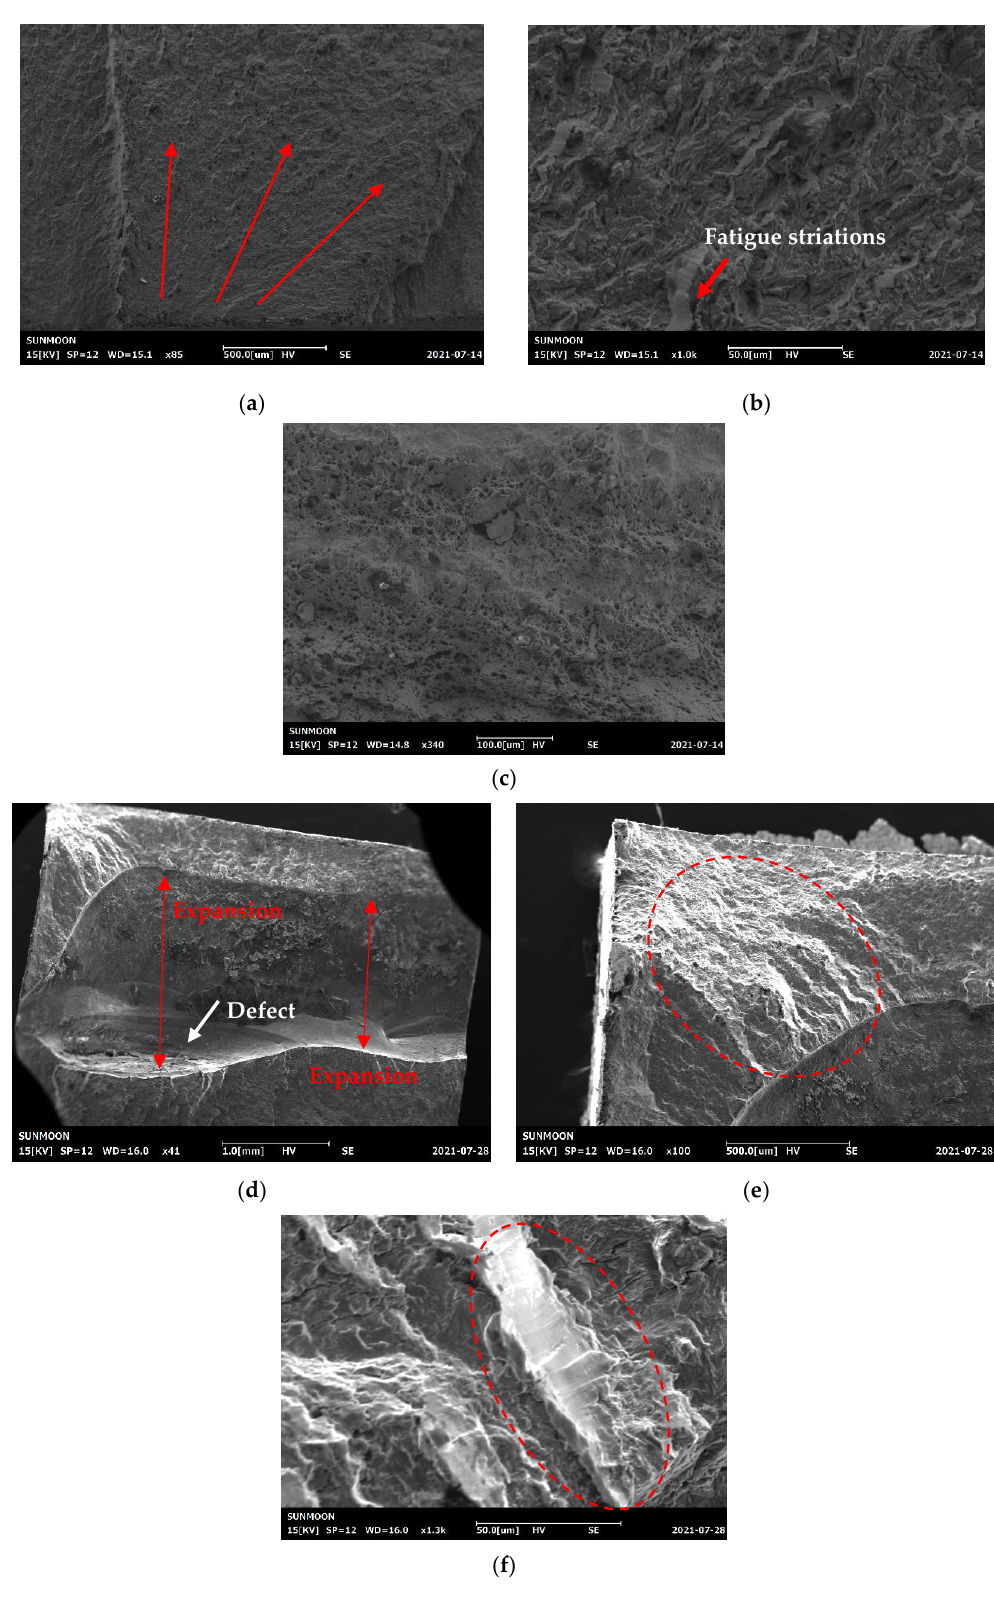
Figure 9. SEM images of the fracture surface of the normal welded specimen. ( a ) Low-magnification image; ( b ) High-magnification image; ( c ) High-magnification image of final fracture area. SEM images of the fracture surface of the overlap-defect welded specimens. ( d ) Low-magnification image; ( e ) Fatigue striation region; ( f ) High-magnification image of fatigue